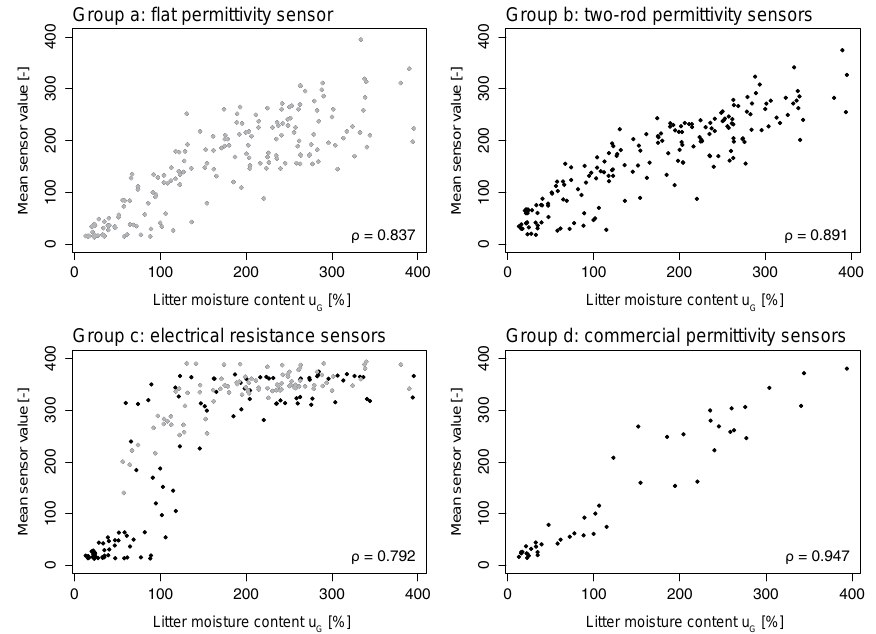
Figure 5. Mean rescaled sensor values vs. manually determined litter moisture content u G for all data available. Gray dots indicate means that were calculated from less than three observations; Spearman’s correlation coefficients ( ρ ) are based on all available data (black and gray dots). All correlations are highly statistically significant ( p < 0.001).